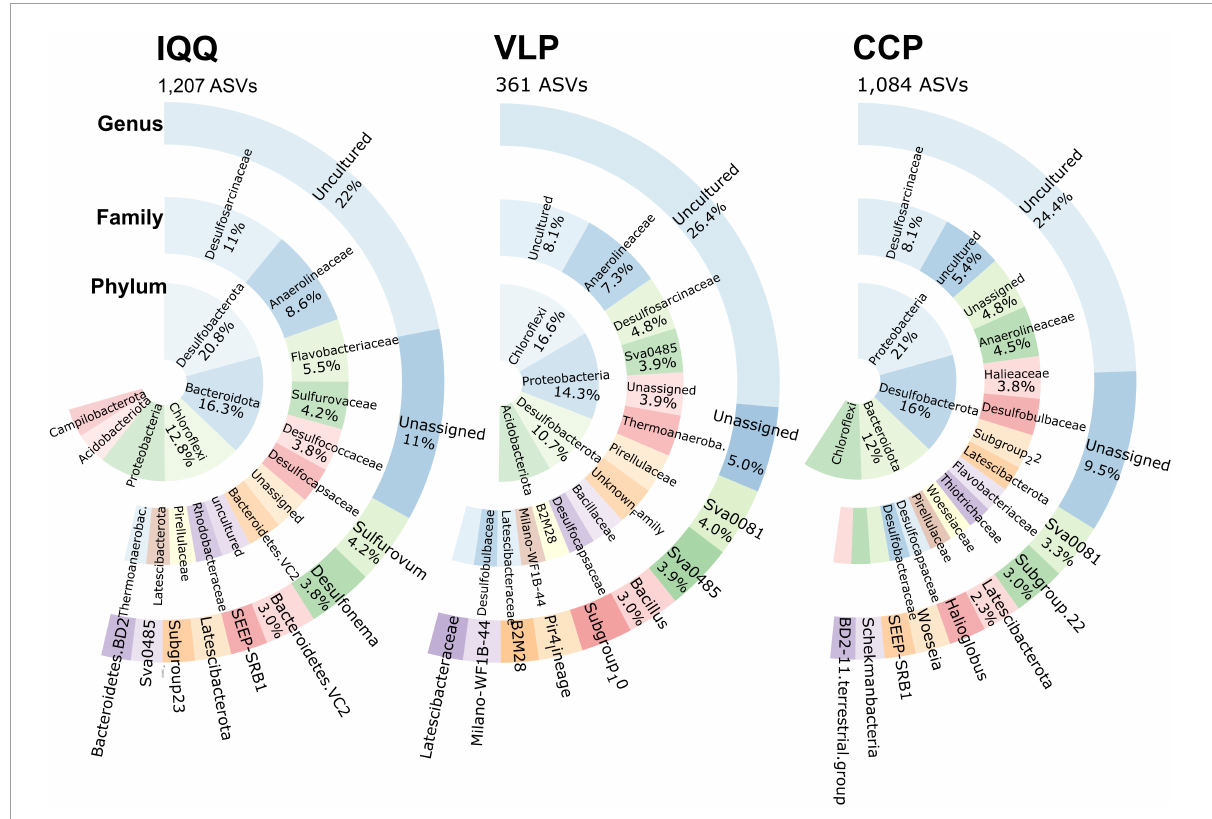
FIGURE5 Relative abundance of the most frequent unique ASVs and its taxonomic assignment at the phyla, family, and genus levels by